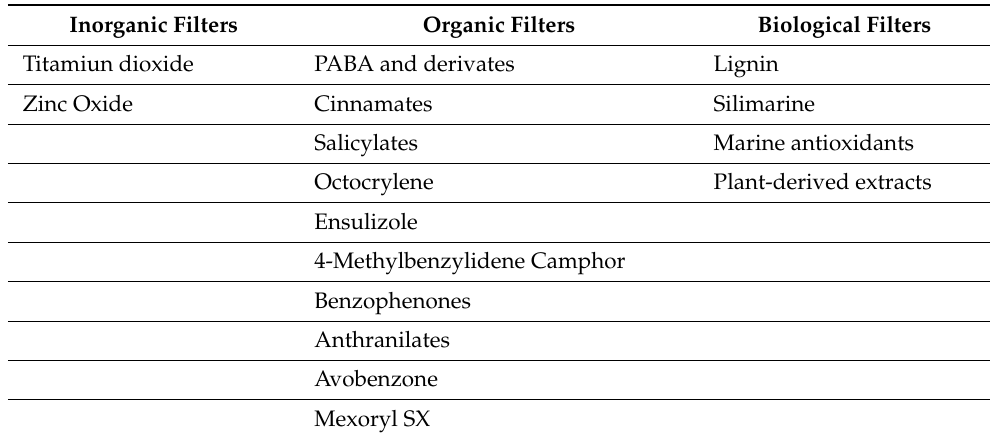
Table 2. Classification of different compounds used as filters. Inorganic Filters Organic